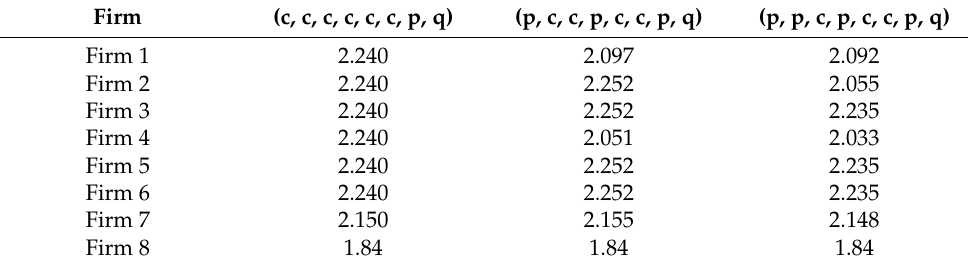
Table 5. Prices of the Nash equilibrium.